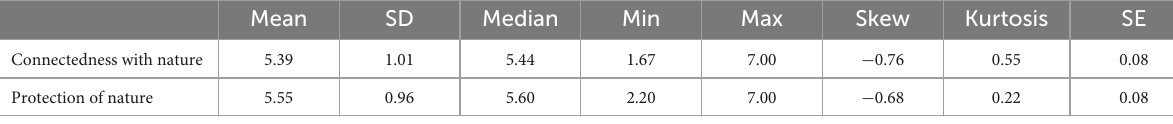
TABLE 2 Descriptive statistics of the two factors of the scale.